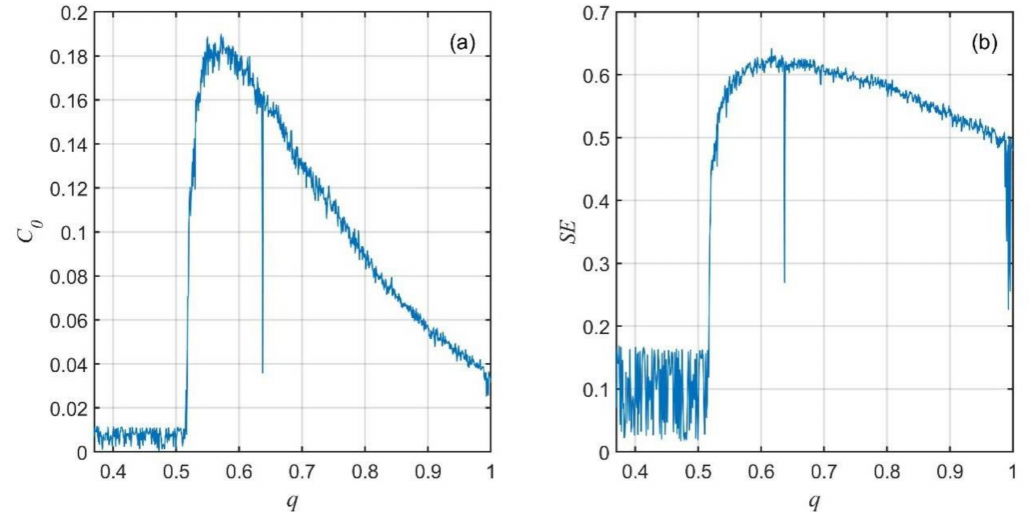
Figure 7. Complexity of system (14) with q varying from 0.37 to 1 for a 1 = 0.3. ( a ) C 0 complexity.